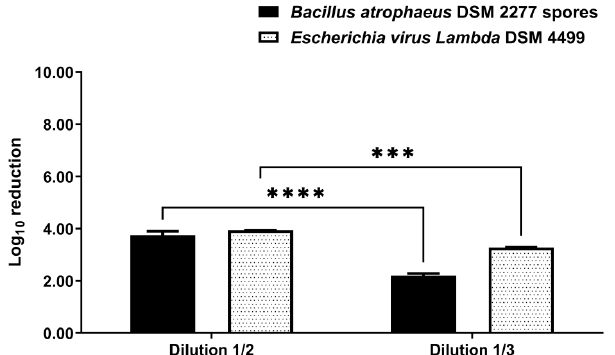
Figure 2. Log 10 reduction achieved in disinfection of fabric by nebulization in a 0.08 m 3 closet. VIRCOV BAC 360 disinfectant was tested at 1/2 ( v / v ) and 1/3 ( v / v ) dilutions. The indicators tested were B. atrophaeus DSM 2277 spores and bacteriophage Escherichia virus Lambda DSM 4499. The disinfection time consisted of 2 min of disinfectant nebulization plus 5 min of rest without nebulization. The error bars in the graph represent the standard deviation of the mean of two replicates ( n = 2) for B. atrophaeus DSM 2277 spores tests and three replicates ( n = 3) for bacteriophage Lambda DSM 4499 tests. Statistical difference between groups was evaluated by two-way ANOVA with post hoc comparisons made by the Tukey test. ***: significant with p -value < 0.001; ****: significant with p -value < 0.0001.